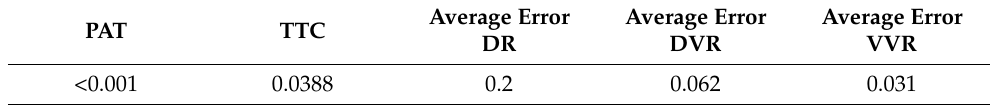
Average Error Average Error Average Error DR DVR VVR